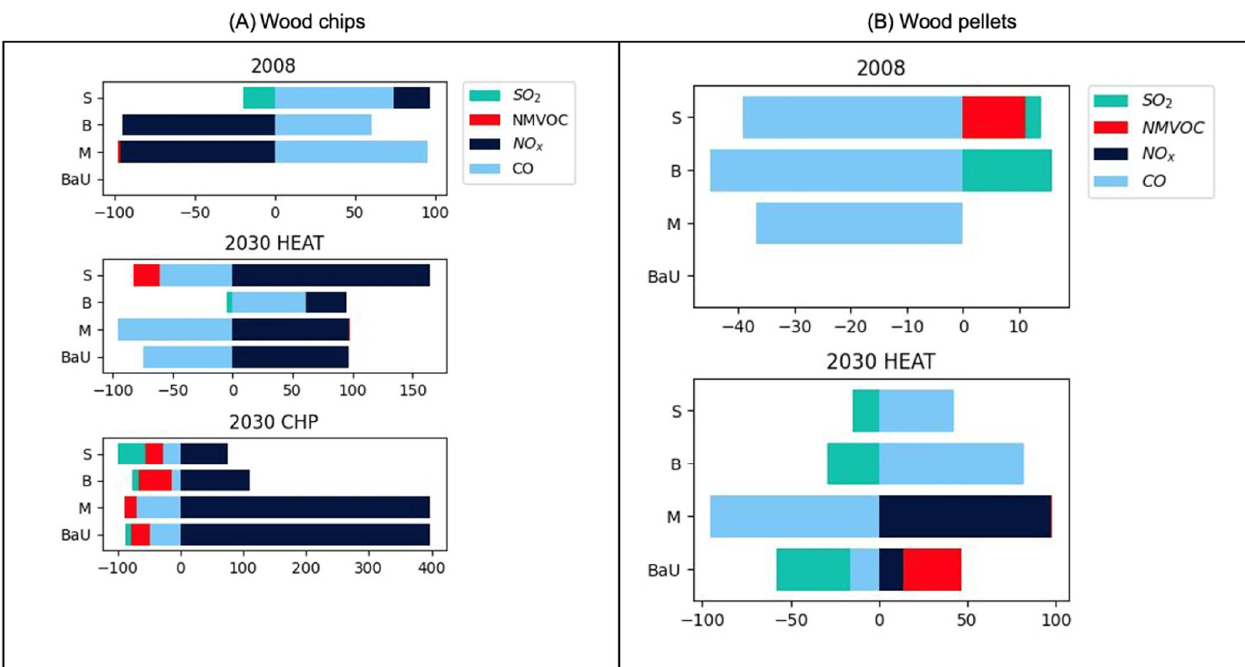
Figure 3. Non-GHG (CO, NMVOC, NO x , and SO 2 ) emissions for wood chip ( A ) and wood pellet ( B ) value chain scenarios, expressed as a percentage of 2008BaU emissions.